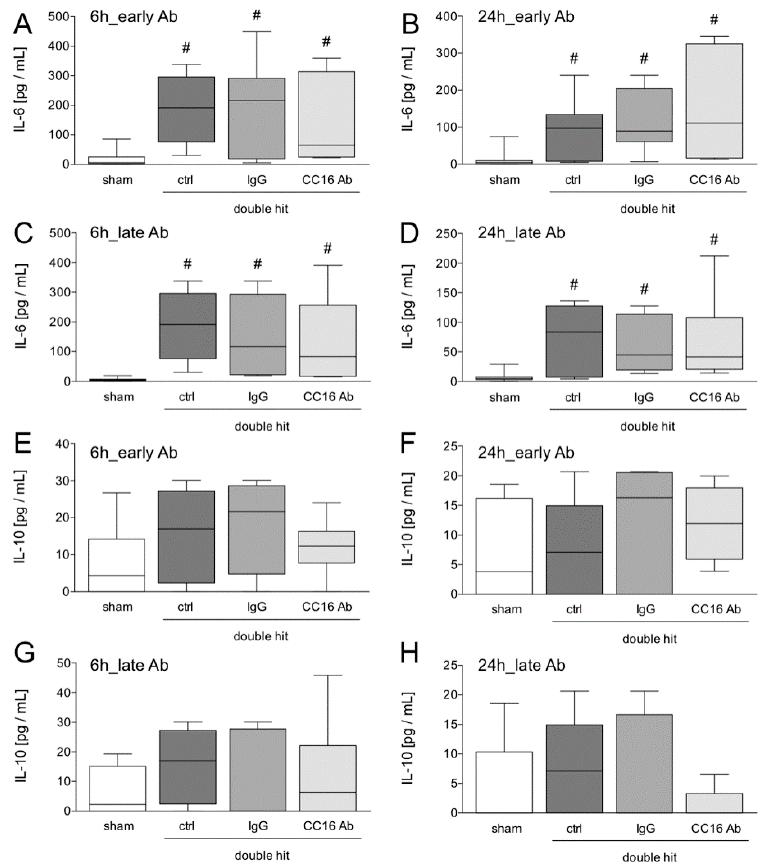
Figure 3. Systemic interleukin (IL)-6 ( A – D ) and IL-10 ( E – H ) levels are shown. Interventions with either the CC16 antibody (Ab) or IgG control (IgG) antibody were performed either early (post TxT, A–B and E–F) or late (post-CLP, C–D, and G–H) to the lungs. Six or 24 hours later, the animals were euthanized for sampling. #: p < 0.05 versus sham, n = 8.